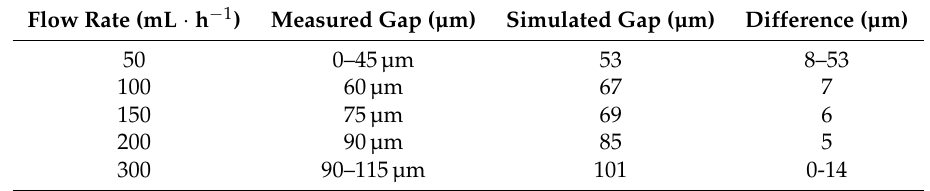
Table 5. Gap heights over the aggregate at different flow rates in the simulation. The differences between the measured and simulated gap values based on Table 1 are also